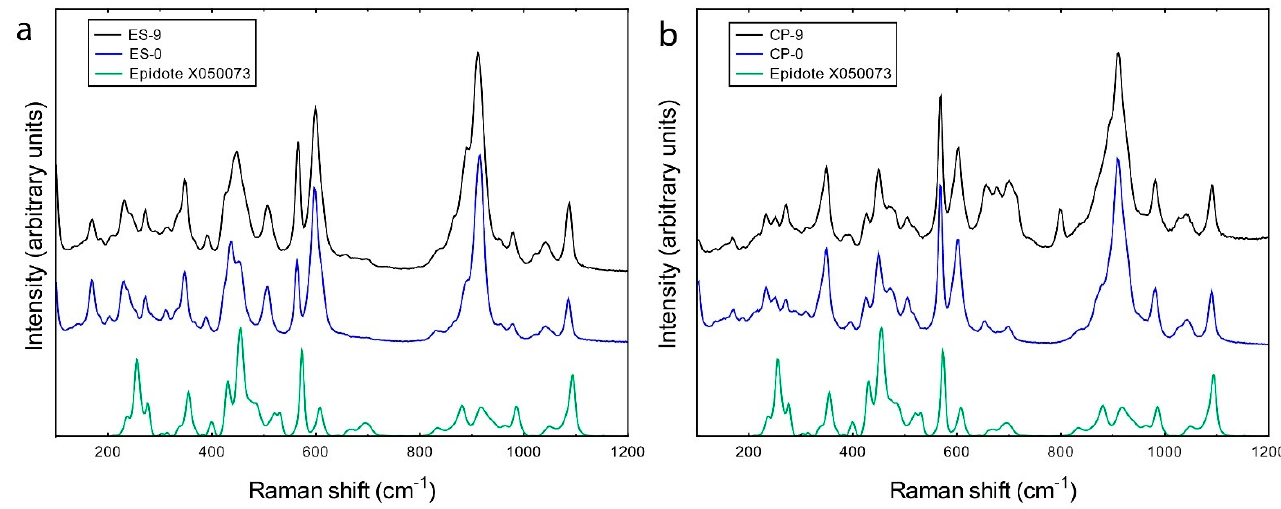
Figure 6. The Raman spectra of epidote ( a ) and clinozoisite ( b ), natural samples and heated at 900 °C in the 1200–100 cm − 1 region; our spectra were compared with the published spectrum of epidote [42].